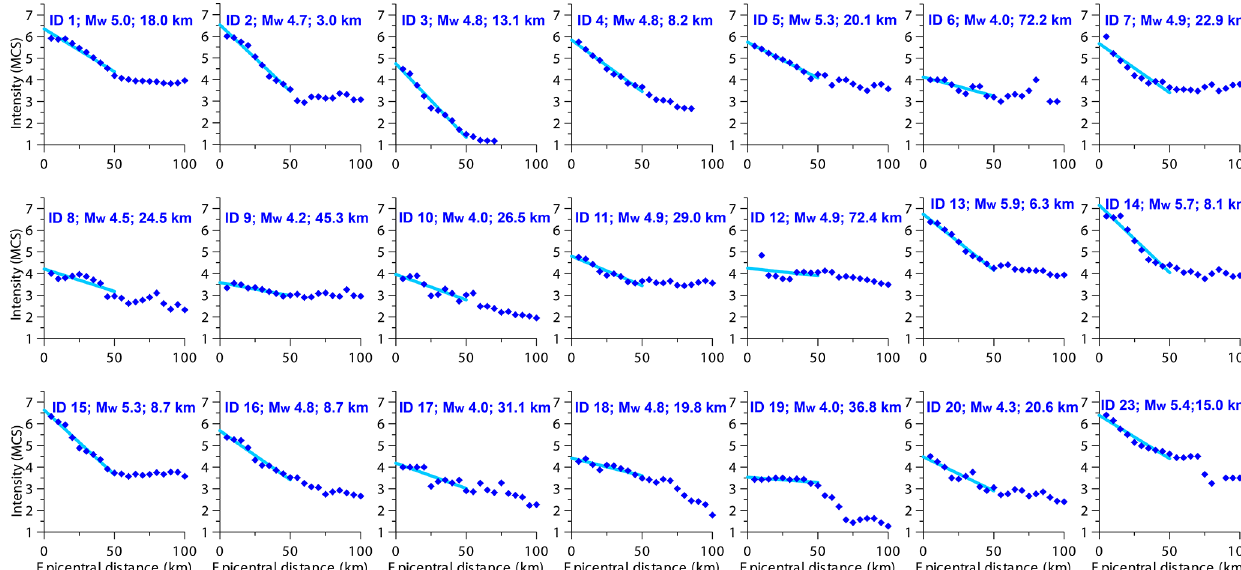
Figure 3. Attenuation curves obtained for the northern Italian earthquakes in the learning set (Table 1, from no. 1 to no. 20, plus no. 23; blue symbols in Figs. 1 and 5). Individual intensity data points were obtained by averaging the intensity values as shown in Fig. 2. We obtained the linear fit for the first 50km of each curve and calculated the resulting steepness.